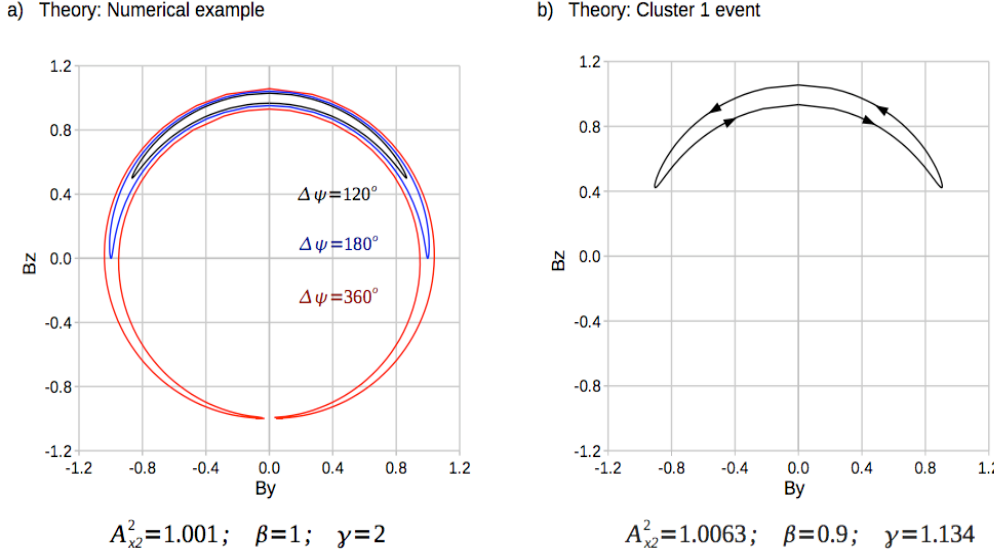
Fig. 3. Examples of tangential hodograms from theory. (a) Hodogram for parameter values at fixed point 2 given by β 2 = 1, A 2 and with ratio of specific heats γ = 2. On the blue curve, the field rotates by 1ψ = 180 ◦ from the left to the right turning point, at both of which B ∗ z = 0, and then by 1ψ = − 180 ◦ back again. For the black curve, 1ψ = 120 ◦ instead, and for the red curve, 1ψ = 360 ◦ . The red curves are separatrices in the hodogram; they intersect at the fixed point 3 (a saddle point) and represent left and right polarized solitary waves. (b) Hodogram for parameter values representative of the Cluster 1 event ( β 2 = 0 . 9; θ 2 = 86 . 2 ◦ ; B ∗ z /B z2 = sin25 ◦ ) , with the values A 2 =1.0063 and γ = 1 . 134 chosen to reproduce the observed separation (Fig. 1) of the inner and outer branch of the hodogram at the x2 symmetry point ( B y = 0 ) as well as the observed spatial extent of the inner hodogram branch. Arrowheads indicate the sense of field rotation that corresponds to v x /B x >